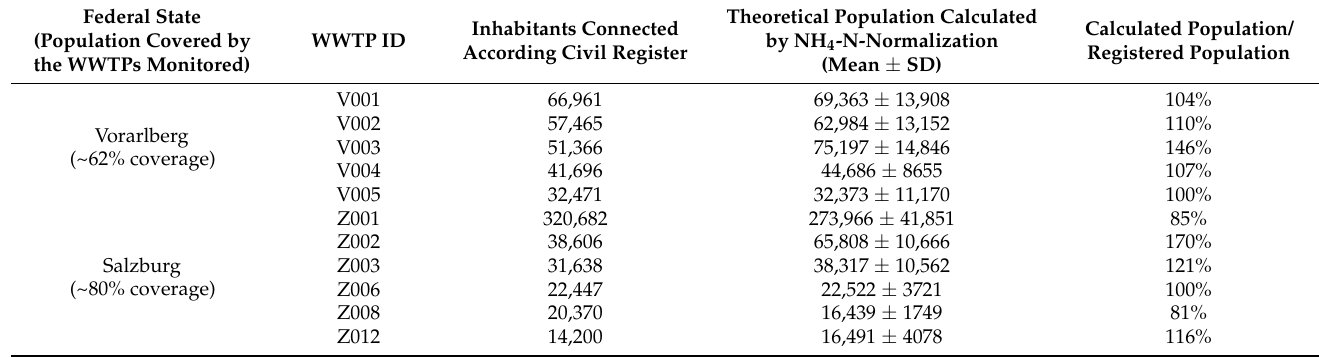
Table 1. WWTPs monitored in this study including relative coverage corresponding to total popula- tion within the two federal states Vorarlberg and Salzburg, and the number of inhabitants connected to each sewage system. Calculated populations across all sampling points per WWTPs are stated as theoretical inhabitants after NH 4 -N normalization. Additionally, the ratio between theoretical and registered inhabitants was calculated in